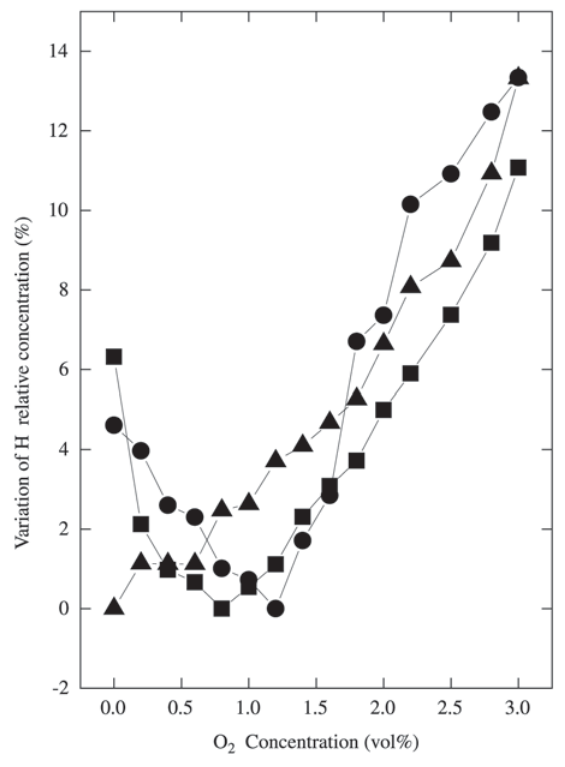
Figure 3. Variation of atomic hydrogen relative concentration with oxygen addition in three different CH (cid:99) 0.5 vol% CH